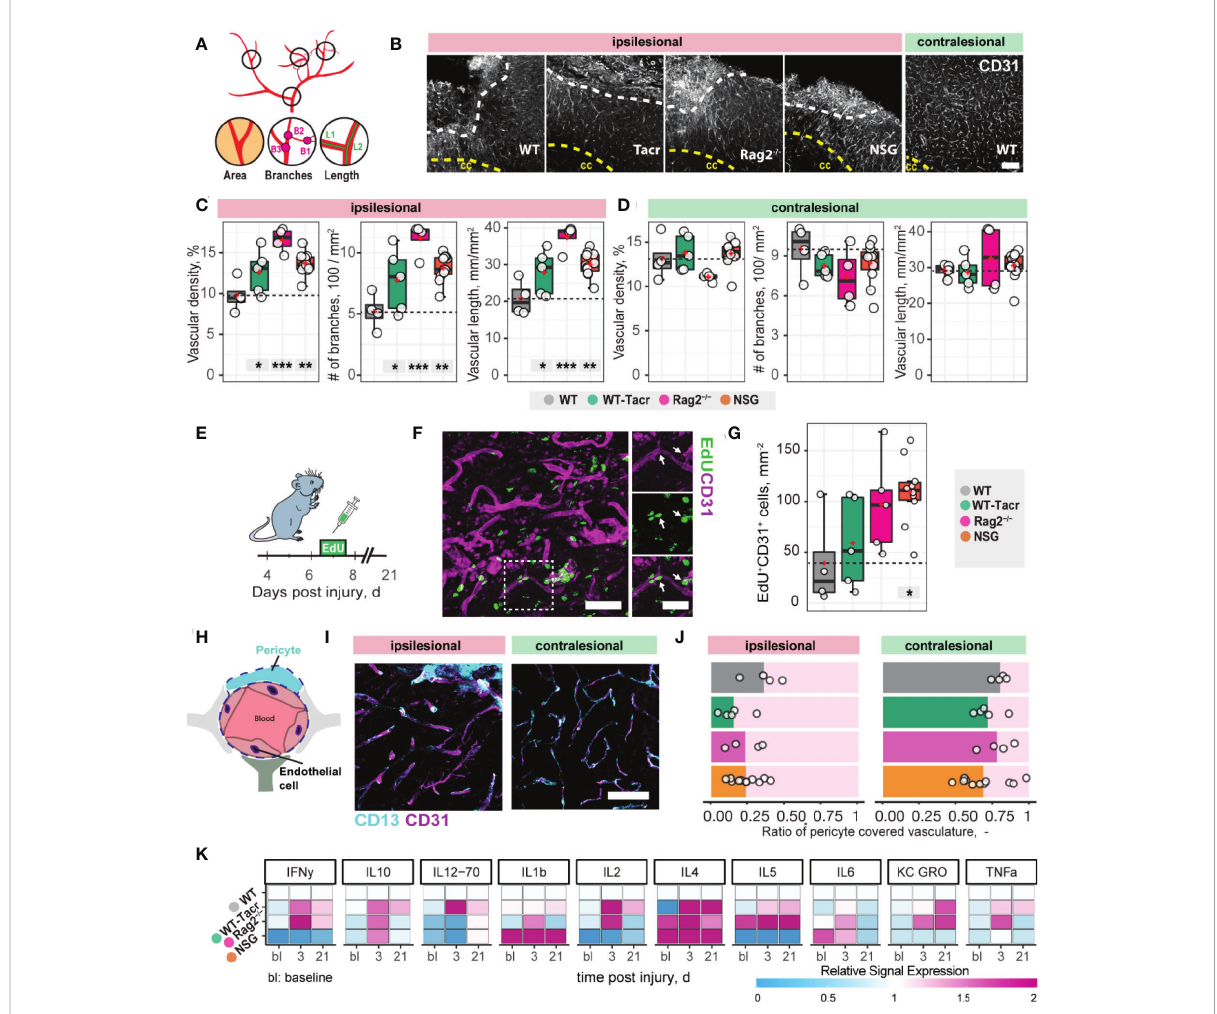
FIGURE 2 Vascular repair and remodelling of immunosuppressed mice after stroke. (A) Schematic representation of vascular parameters. (B) Representative images of CD31 + vasculature in the ipsi- and contralesional cortex in WT mouse. Scale bar: 100 µm. (C) Quanti fi cation of vascular density, number of vascular branches and vascular length of ipsi- and (D) contralesional cortex 21 dpi. (E) Schematic representation of EdU injection to label proliferating cells 7 dpi. (F) Representative image of EdU incorporating CD31 + blood vessels in the ipsilesional site at 21 dpi. Arrow shows EdU + vasculature. (G) Quanti fi cation of EDU + CD31 + cells per mm 2 in the ipsilesional site. (H) Schematic representation of blood brain barrier components. (I) Representative image of CD31 + cells covered by CD13 + pericytes in the ipsi-and contralesional site of WT mice at 21 dpi. Scale bar: 25 µm. (J) Quantitative ratio of vasculature covered by pericytes in ipsi- and contralesional site. (K) Blood plasma cytokine analysis of pro-in fl ammatory factors at baseline, 3 and 21 dpi. Data are shown as mean distributions where the red dot represents the mean. Boxplots indicate the 25% to 75% quartiles of the data. For boxplots: each dot in the plots represents one animal. Signi fi cance of mean differences between the groups (baseline hemisphere, contralesional hemisphere, and ipsilesional hemisphere) was assessed using Tukey ’ s HSD. Asterisks indicate signi fi cance: *P < 0.05, **P < 0.01, ***P < 0.001. ctx, cortex; cc, corpus callosum; bl, baseline; d,